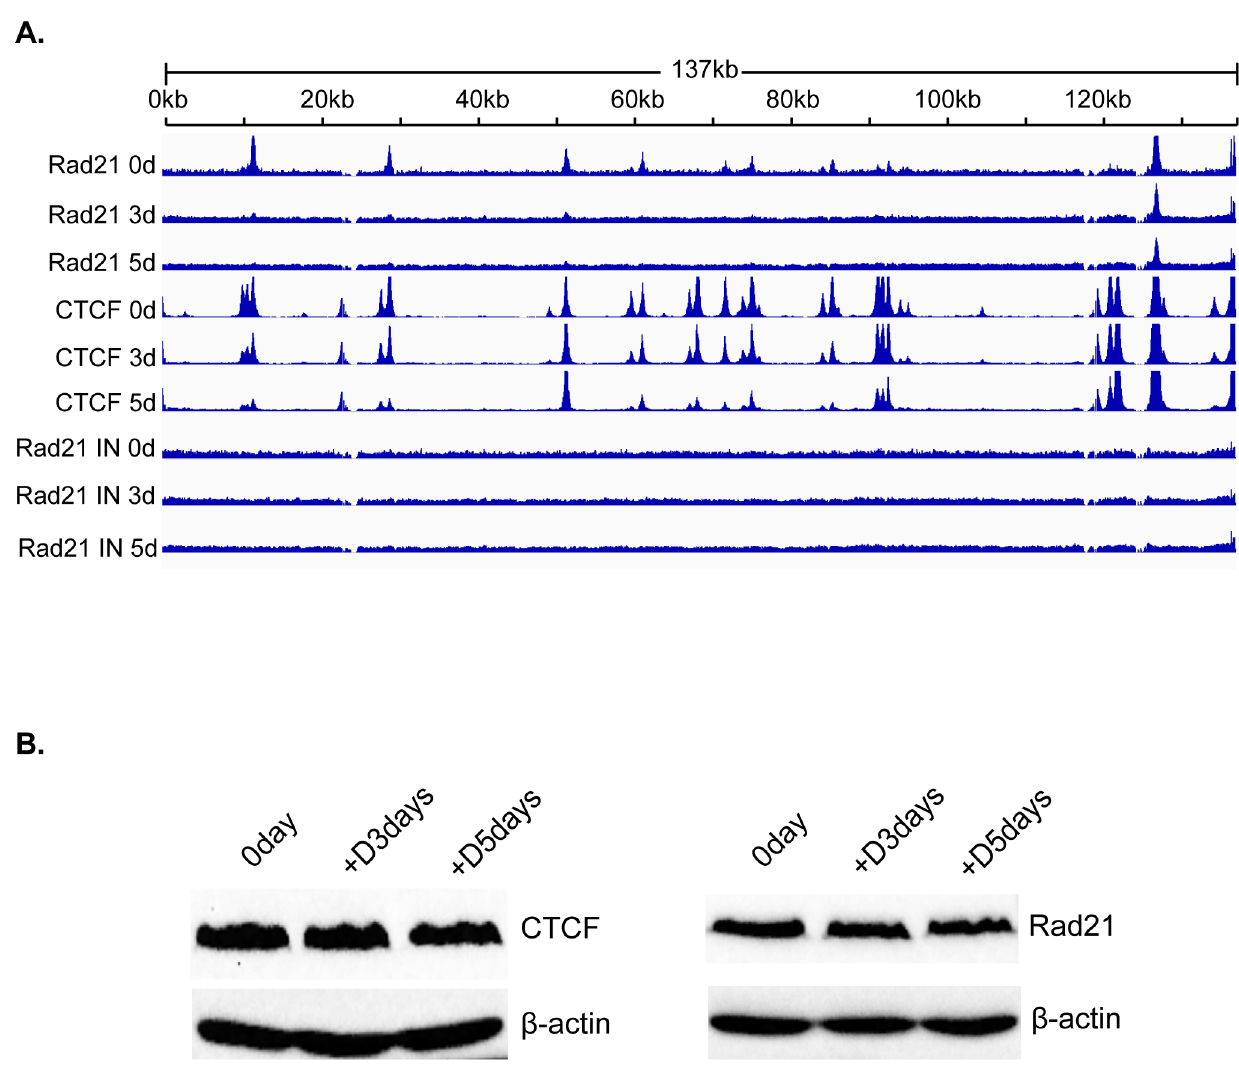
Figure 5. Changes in Rad21 binding to the KSHV genome during KSHV reactivation and lytic replication. A. ChIP-SEQ assays were performed on cell samples harvested at 0 d, 3 d, and 5 d after induction of lytic KSHV replication in iSLK cells. Relative read numbers are plotted on the vertical axis versus the reference KSHV genome map on the horizontal axis. Rad21 ChIP results from each time point are shown on the upper three panels and the corresponding CTCF ChIP results are shown on the middle three panels for comparison. The corresponding input samples (IN) are shown on the lower three panels. The tracks depict coverage per base, scaled per million mapped KSHV reads. B. CTCF and Rad21 levels in iSLK cells during KSHV replication. Protein lysates from iSLK cells at 72 and 120 hours after induction of lytic replication were immunoblotted with anti- CTCF or Rad21 antibodies. Blots were stripped and re-probed with anti-actin antibody as a loading control (lower panels).